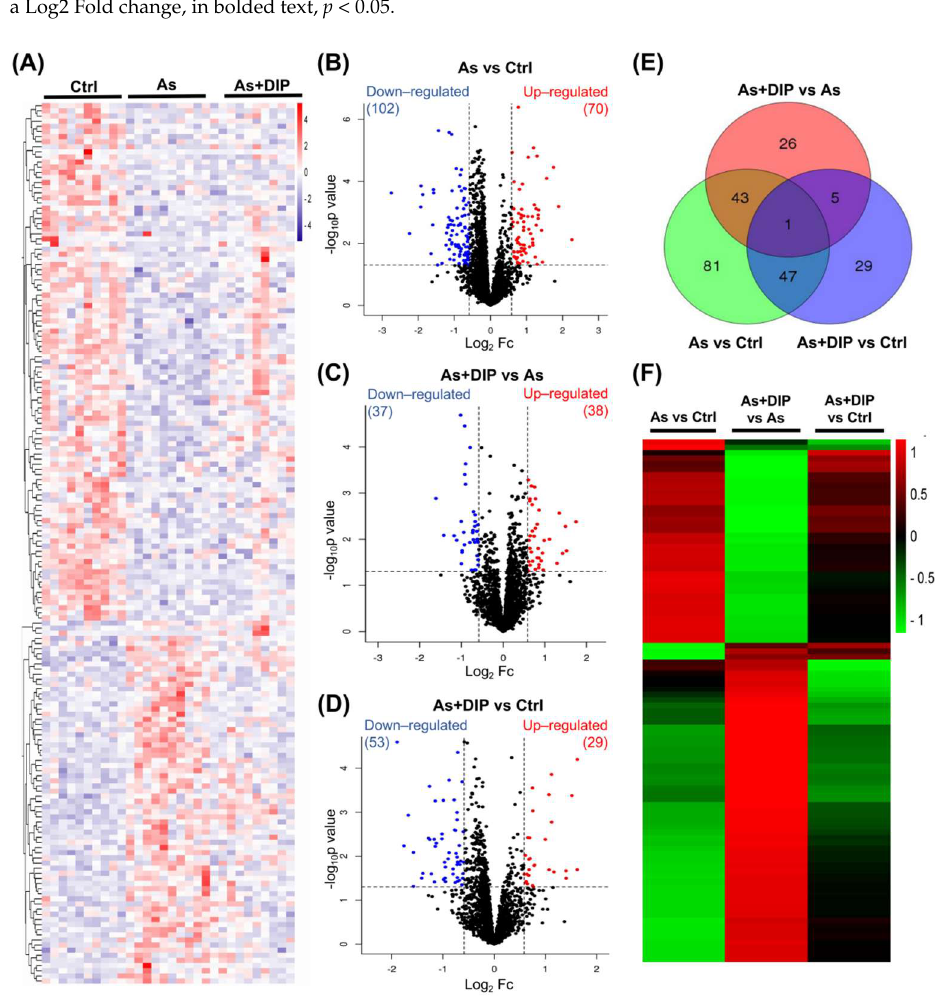
Figure 2. Differentially expressed proteins identified in different groups. ( A ) Cluster map comparing the proteins identified in the As/Ctrl, DIP + As/As, and DIP + As/Ctrl groups. Red color indicates higher expression (upregulation), blue indicates lower expression (downregulation), and white indicates similar expression levels. ( B ) Volcano plots depicted the distribution of proteins in the As/Ctrl group. ( C ) Volcano plots depicted the distribution of proteins in the As + DIP/As group. ( D ) Volcano plots depicted the distribution of proteins in the As + DIP/Ctrl group. For parts ( B – D ), the log 2 fold change (FC) is plotted versus the − log 10 of the p -value. Red dots = hits with p < 0.05 and mean log 2 FC > 0.58; blue dots = hits with p < 0.05 and mean |log 2 FC| < 0.58. ( E ) Venn diagrams of DEPs among the As/Ctrl group, As + DIP/As group, and As + DIP/Ctrl. ( F ) The cluster analysis results of different groups of